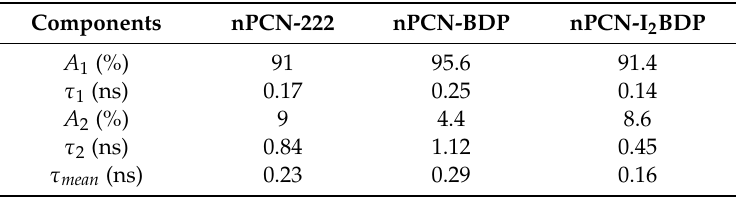
Table 2. Fitting parameters for fluorescence decay curves of acceptor emission of nPCN-BDP, I 2 BODIPY, and nPCN-I 2 BDP shown in Figure